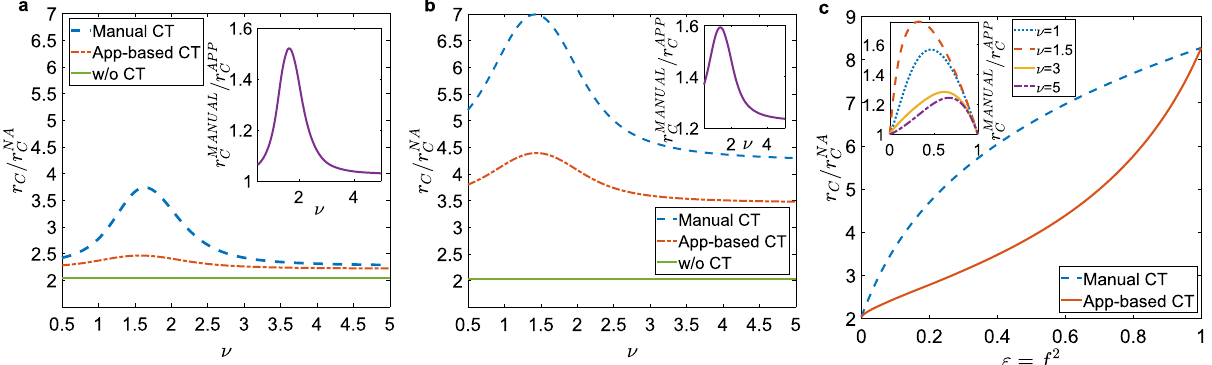
Fig. 3 Effects of heterogeneity. a Plot, as a function of the exponent ν , of the ratio between the epidemic threshold r C in the presence of CT protocols and the epidemic threshold of the non-adaptive case r NA . We set ϵ = f 2 = 0.1 ( f ≈ 0.316). In the inset we plot the ratio between the epidemic threshold of the C